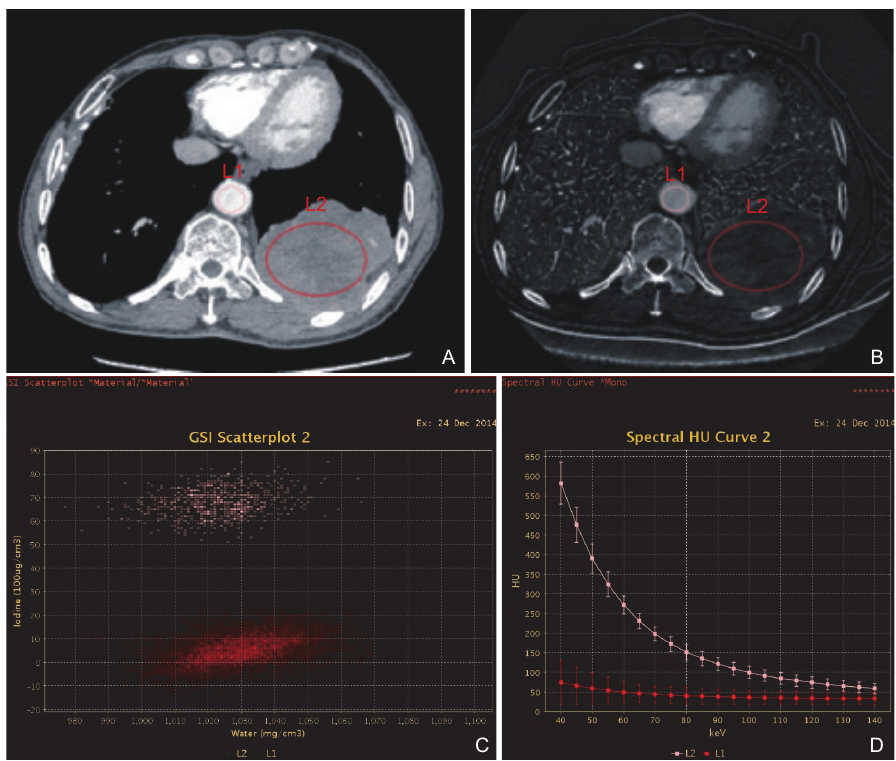
Figure 3 Axial monochromatic CT image (A) and iodine-based material decomposition image (B) of a 62-year-old man diagnosed with peripheral SqCC measuring 11 cm in the left lower lobe of the lung. L1 and L2 represented the measurements of iodine concentration of tumor (maximun IC les = 29 mg/mL) and descending aorta (IC ao = 60 mg/mL). NIC max then was calculated as 0.48 for this lesion.